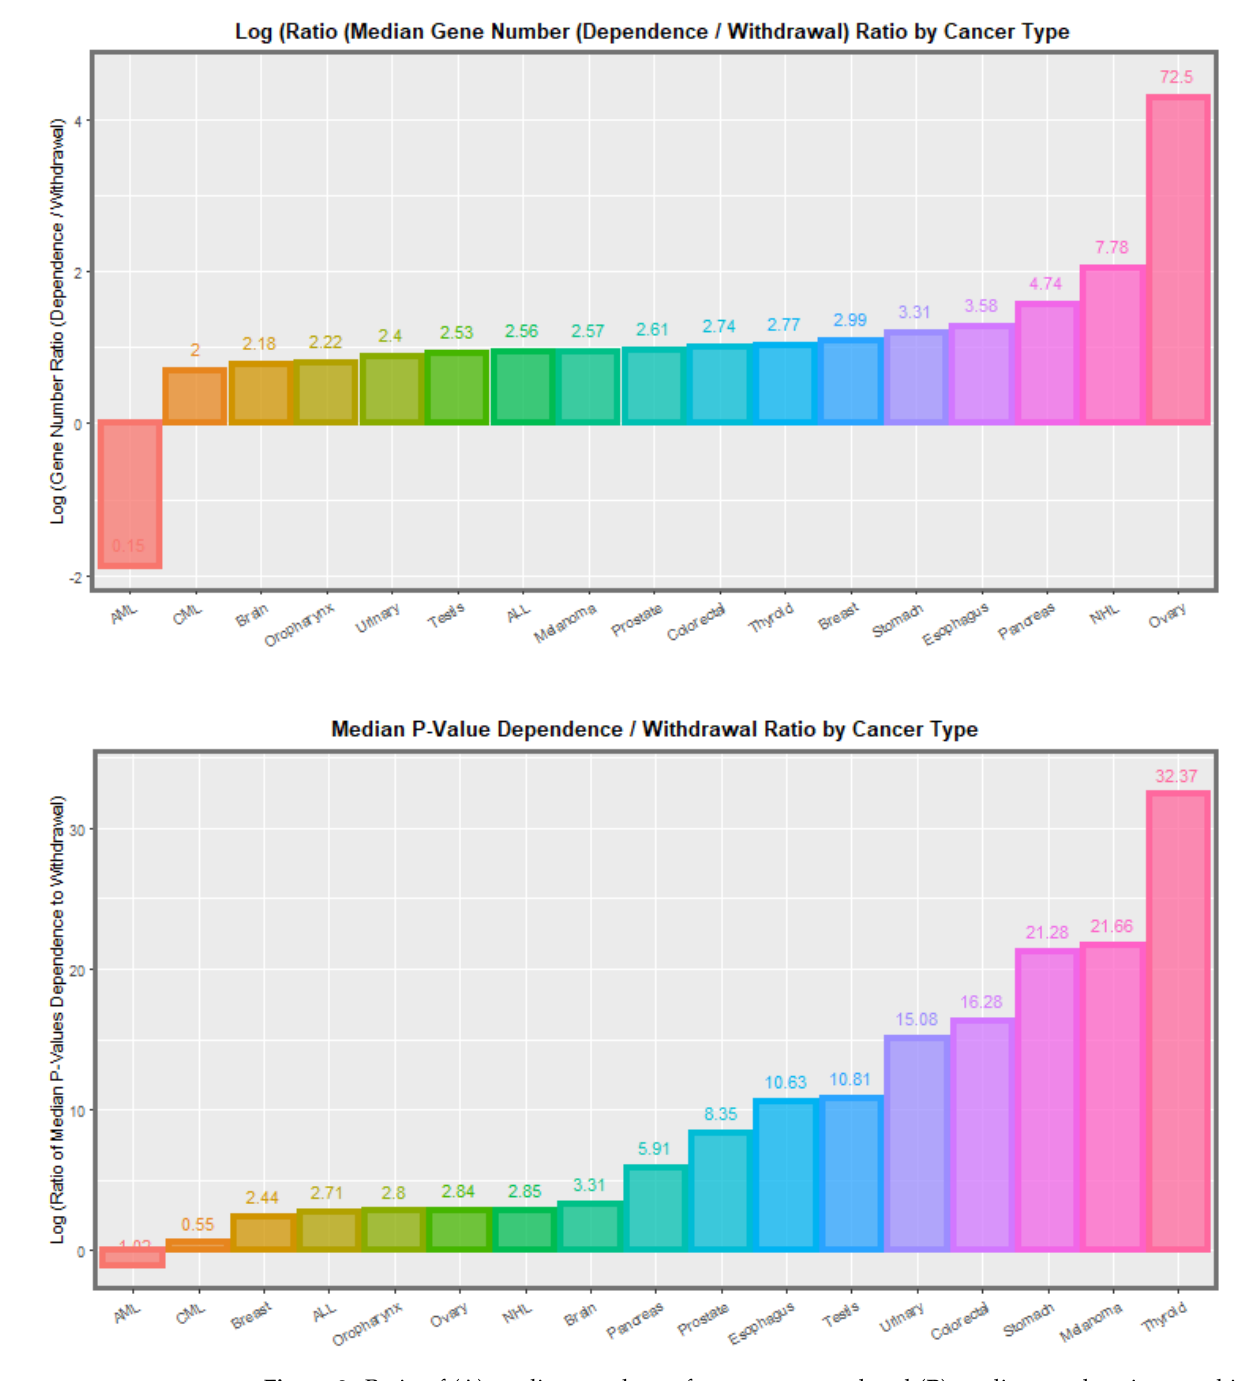
Figure 2. Ratio of ( A ) median numbers of genes annotated and ( B ) median p -values in cannabis dependence to withdrawal (from Table 2). Data relate to differential DNA methylation data from sperm for genes previously linked with cancer. The experimental condition considered in this Figure is the ratio of the data in cannabis dependence to that in cannabis withdrawal. All data from the Schrott data appendix